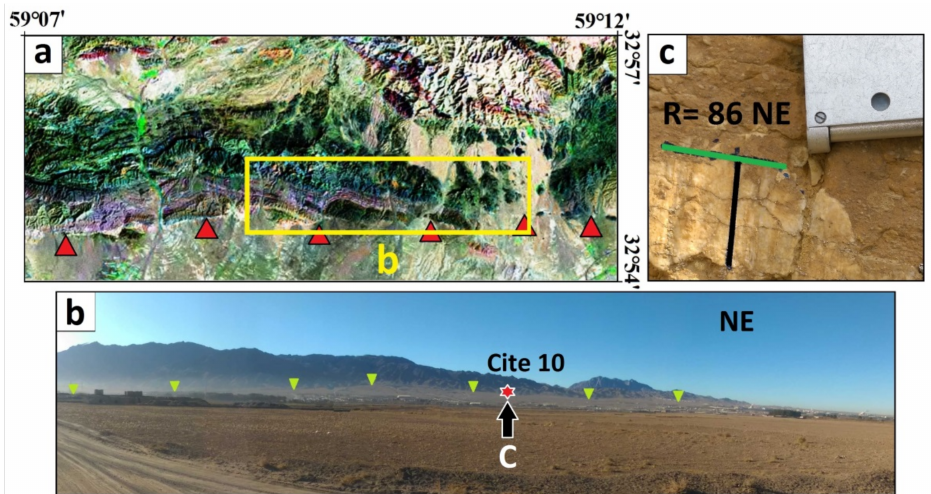
Figure 9. ( a ) Trace of North Birjand Fault (N.B.F) on the satellite image. ( b ) Field photo illustrating the location of the site 10. ( c ) Slickenline on the minor fault part.